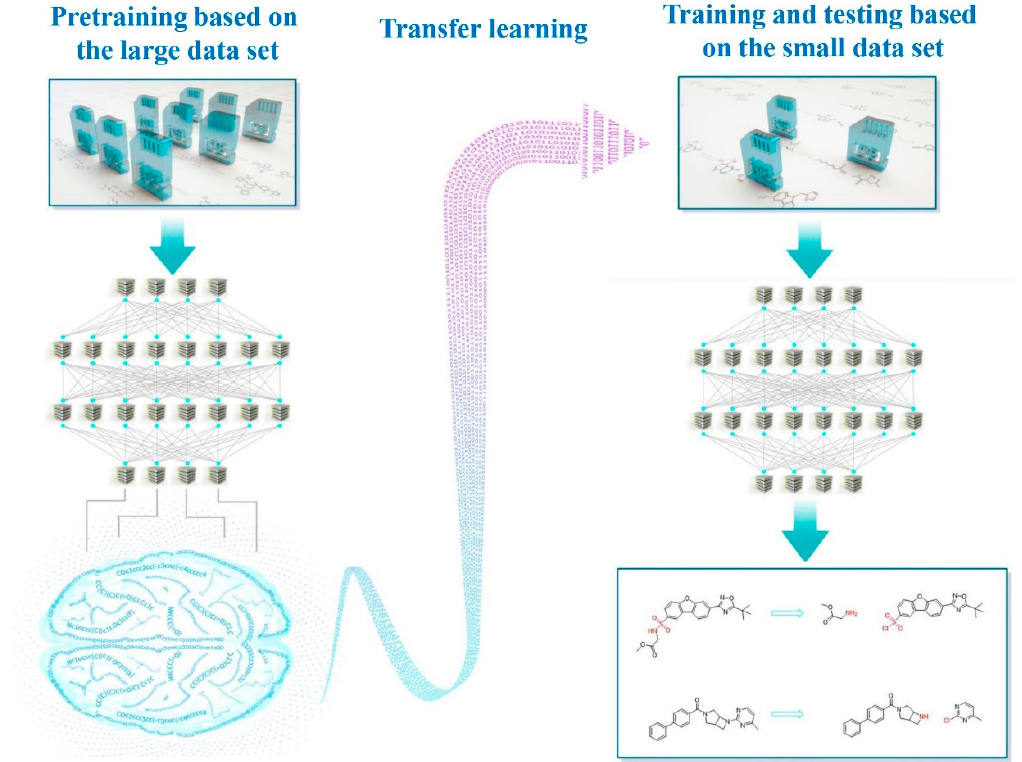
Figure 2. Designing concept and process of transfer-learning-aided retrosynthetic analysis.